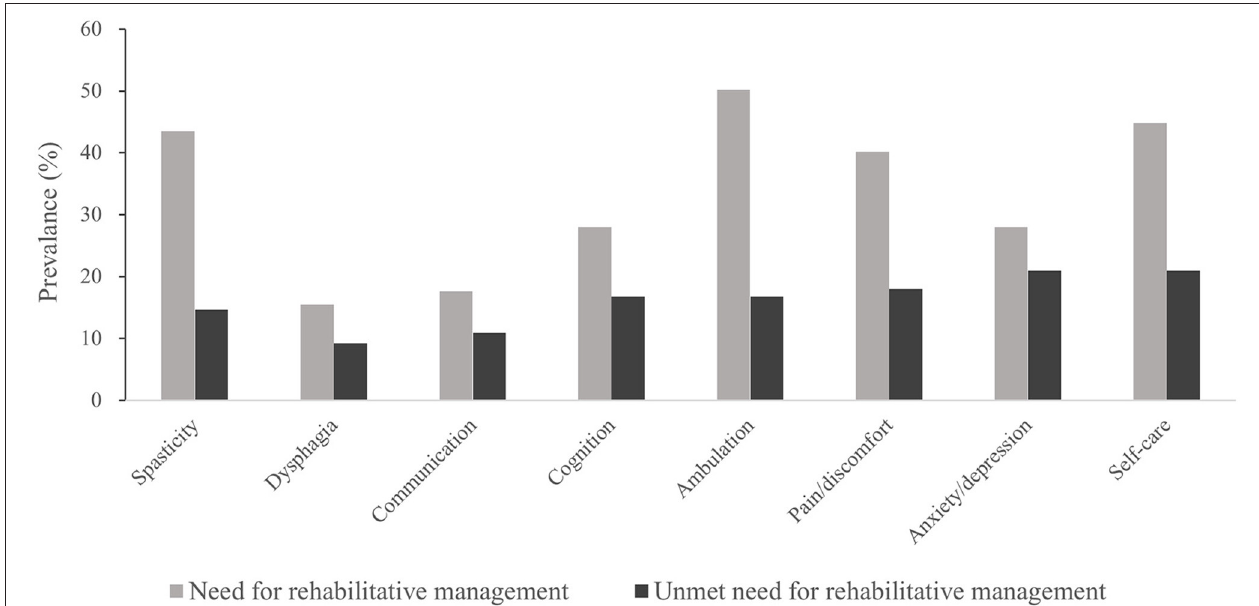
FIGURE 1 | Prevalence of met and unmet needs according to the common problems after stroke.